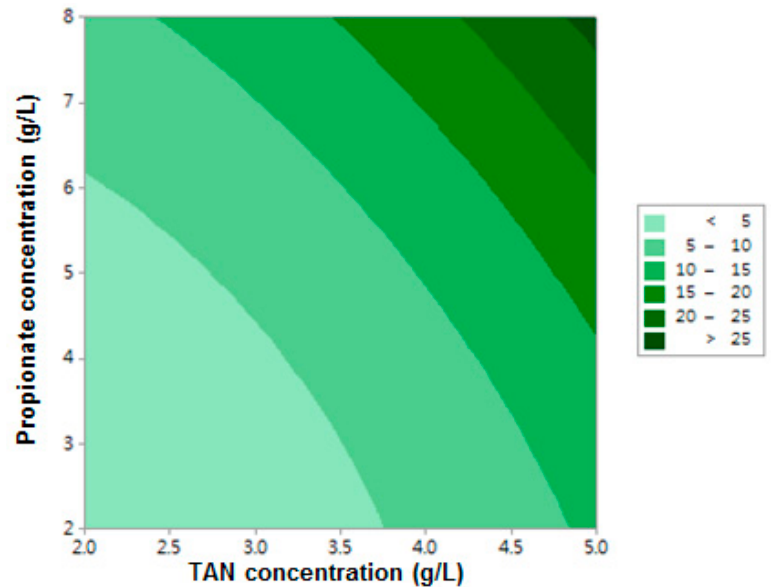
Figure 2. Two-dimensional contour plot of the lag period within the experimental design.